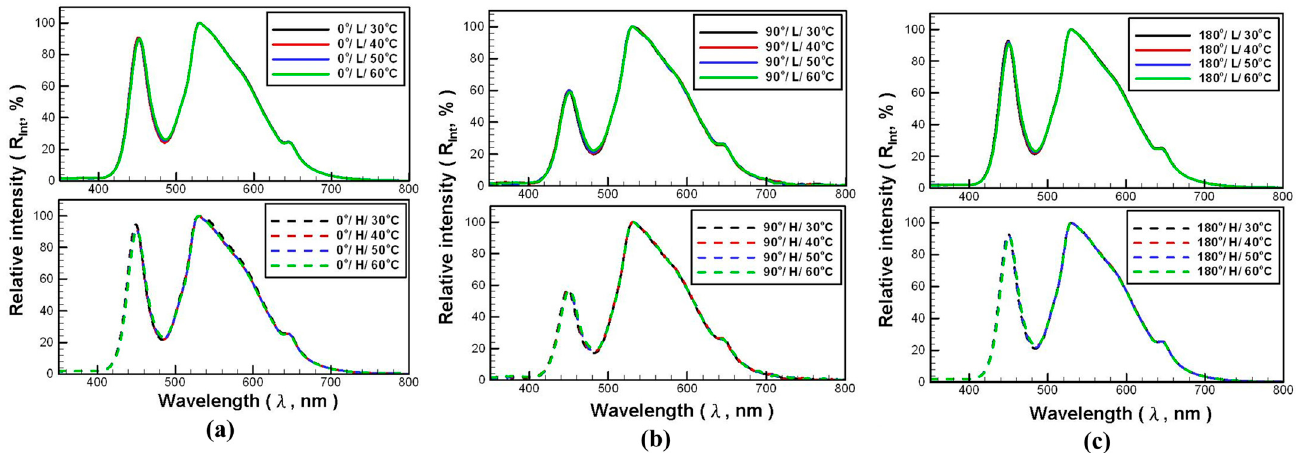
Figure 5. Normalized spectral measurement results of the LED lamp: ( a ) 0 ◦ , ( b ) 90 ◦ , and ( c ) 180 ◦ . Table 2. Correlated Color temperature (CCT), Duv, and chromaticity coordinates of the LED lamp. Deg.